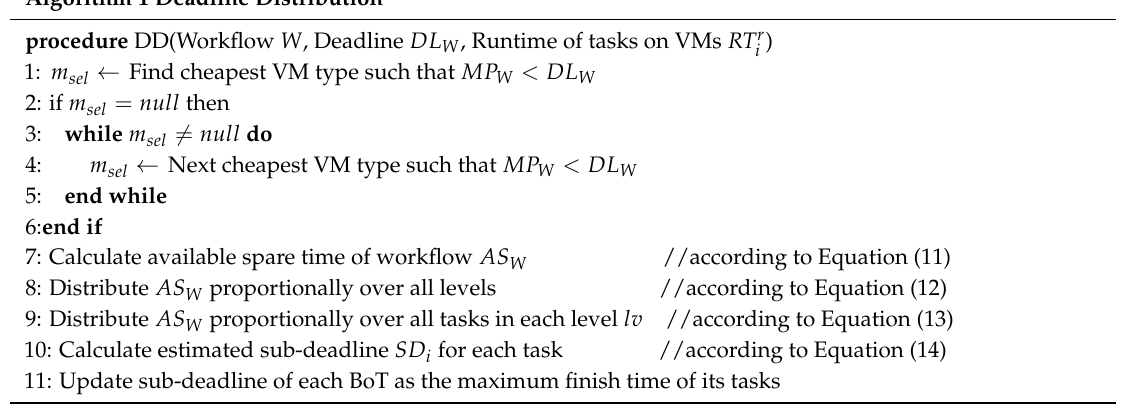
Algorithm 1 Deadline